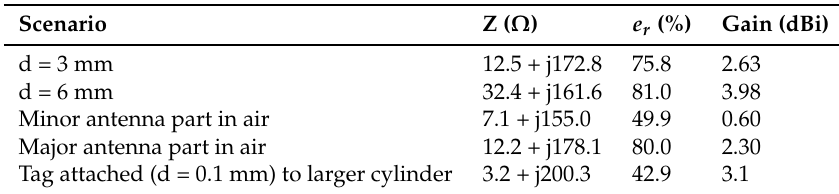
Figure 3. 3D directivity patterns at 920 MHz for tag attached to the twice larger plastic cylinder ( left ), with minor part in the air ( center ), and at 3-mm distance from the plastic cylinder ( right ). Table 2. Impedance, radiation efficiency and gain results of tag antenna attached to plastic product in different scenarios at 920